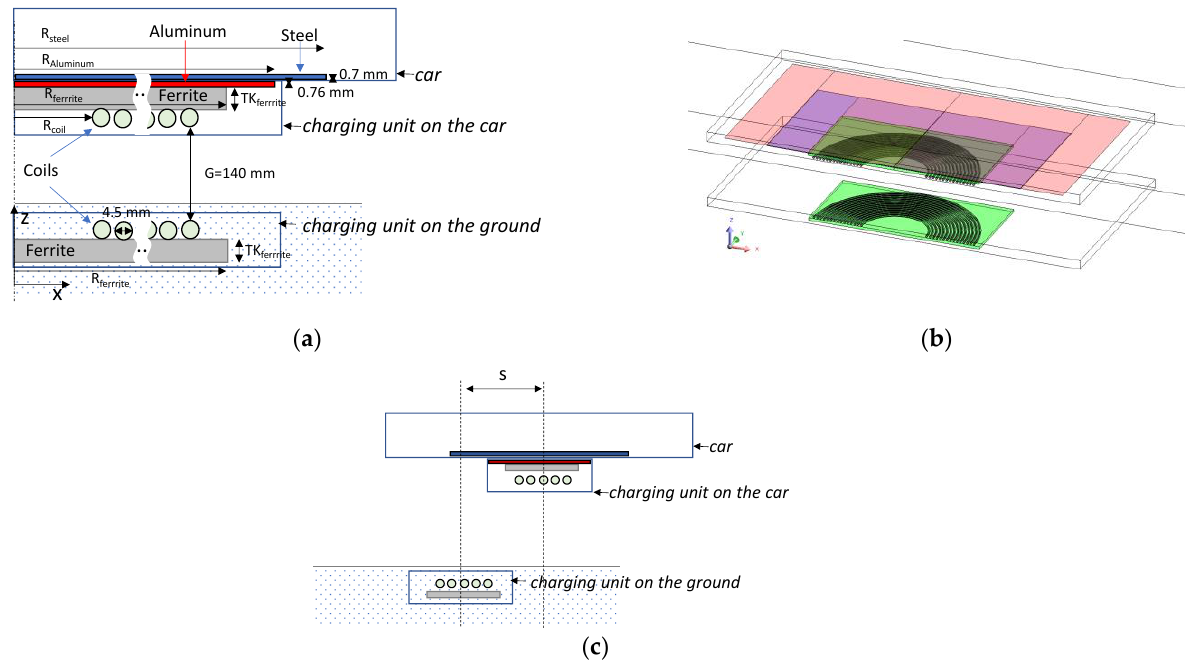
Figure 1. Cross-section of the geometry: the layers approximated with the shell formulation are highlighted on the right ( a ), the FEM geometry ( b ). In ( c ) the vertical cross section with the shift parameter s of the car with respect to the ground recharge unit. Table 1. Electrical characteristics of the material used in FEM model.